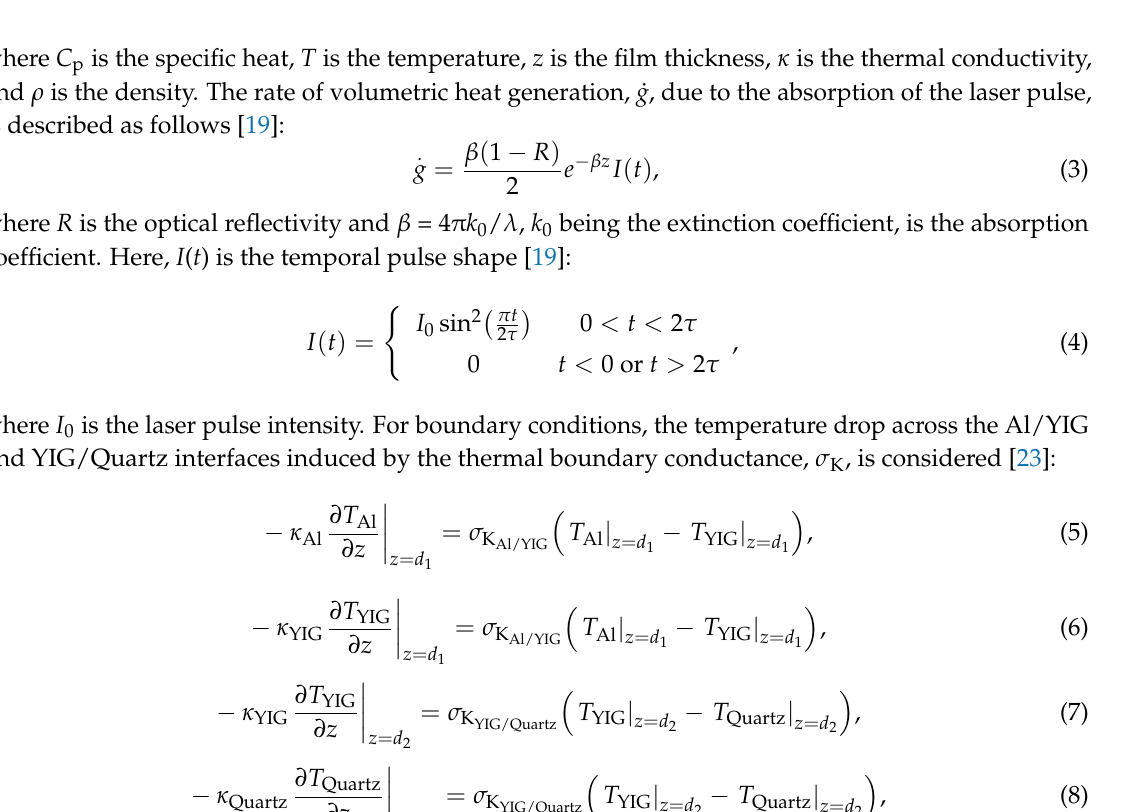
Figure 2. A schematic of the thermoreflectance measurement principle. The pump-pulse heats up the aluminum (Al) sample surface, and the probe-pulse monitors the reflectance change during the heat diffusion into the film thickness direction.